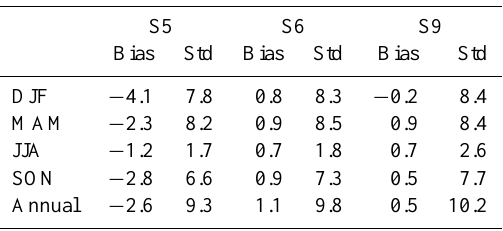
Table 1. Comparison between seasonal and annual modelled and observed 2m temperature [ ◦ C] for the stations S5, S6 and S9 along the K-transect. The bias is calculated between the modelled and ob- served data, the standard deviation (Std) is based on daily observed data over the period August 2003–August 2007.